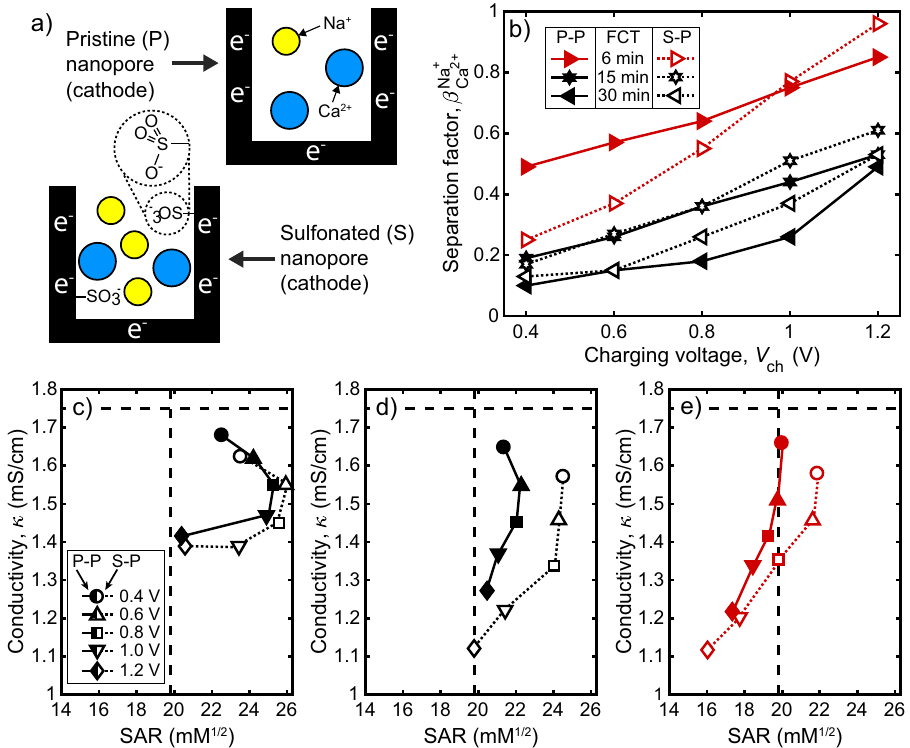
Fig. 4 Experimental selectivity and output water quality. a A schematic representation of a cathode nanopore in the P – P cell and the S – P , for the P – P and S – P cells for full-cycle times (FCTs) of 6, 15, cell containing charged sulfonic (SO 3 − ) groups. b Measured separation factor, β Na þ Ca 2 þ and 30 min. c Measured desalinated water SAR and conductivity for the P – P and S – P cells for FCT of 30, d 15, and e 6 min. In panels c – e , feed conditions are represented by dashed horizontal and vertical